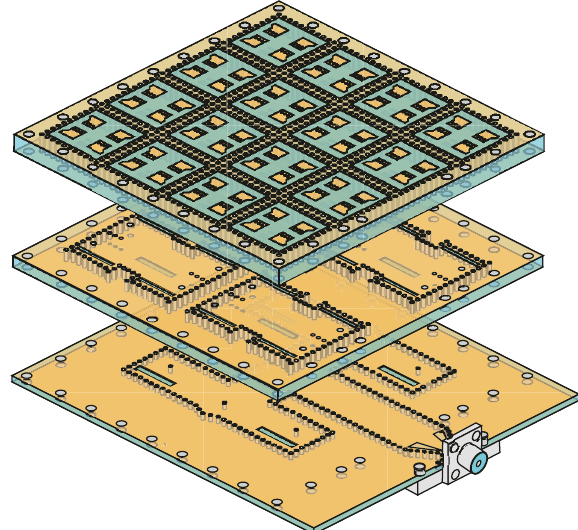
Figure 15: 3D exploded view of the proposed 4 × 4 ME dipole antenna array with two-layer full-corporate SIW feeding network.